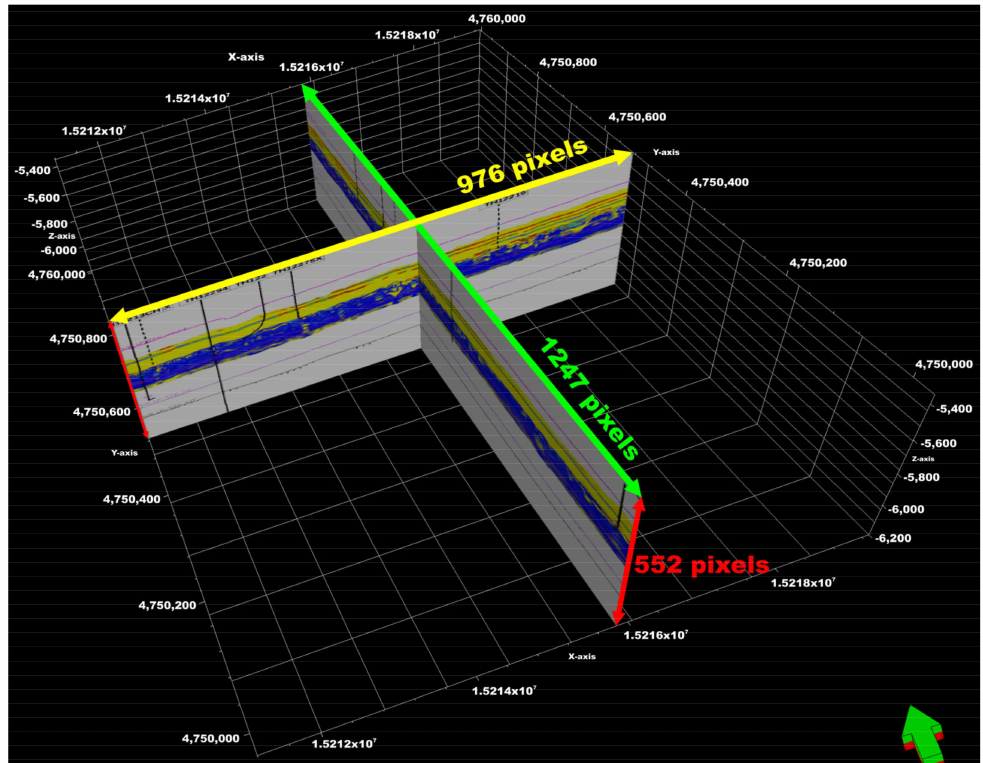
Figure 3. Image introducing dataset sizes and orientation. The green arrow indicates the direction